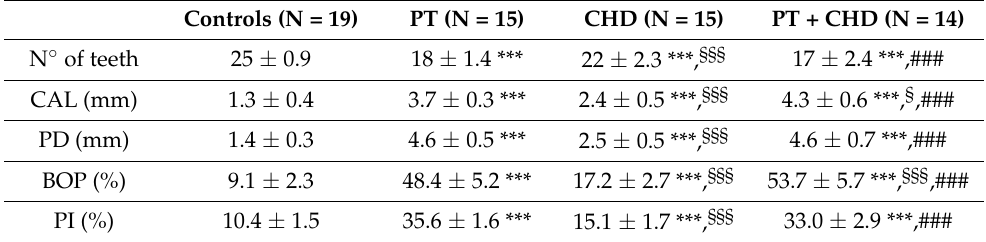
Table 3. Clinical dental variables of recruited